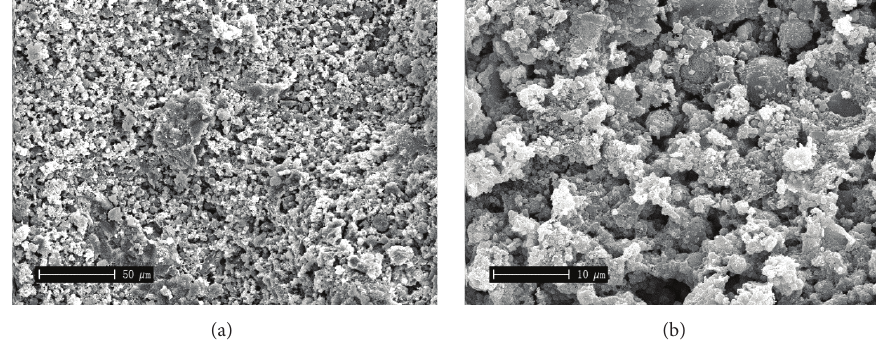
Figure 8: SEM images of microstructure of PC exposed at 300 ∘ C for 4h at (a) 1000x and (b) 5000x